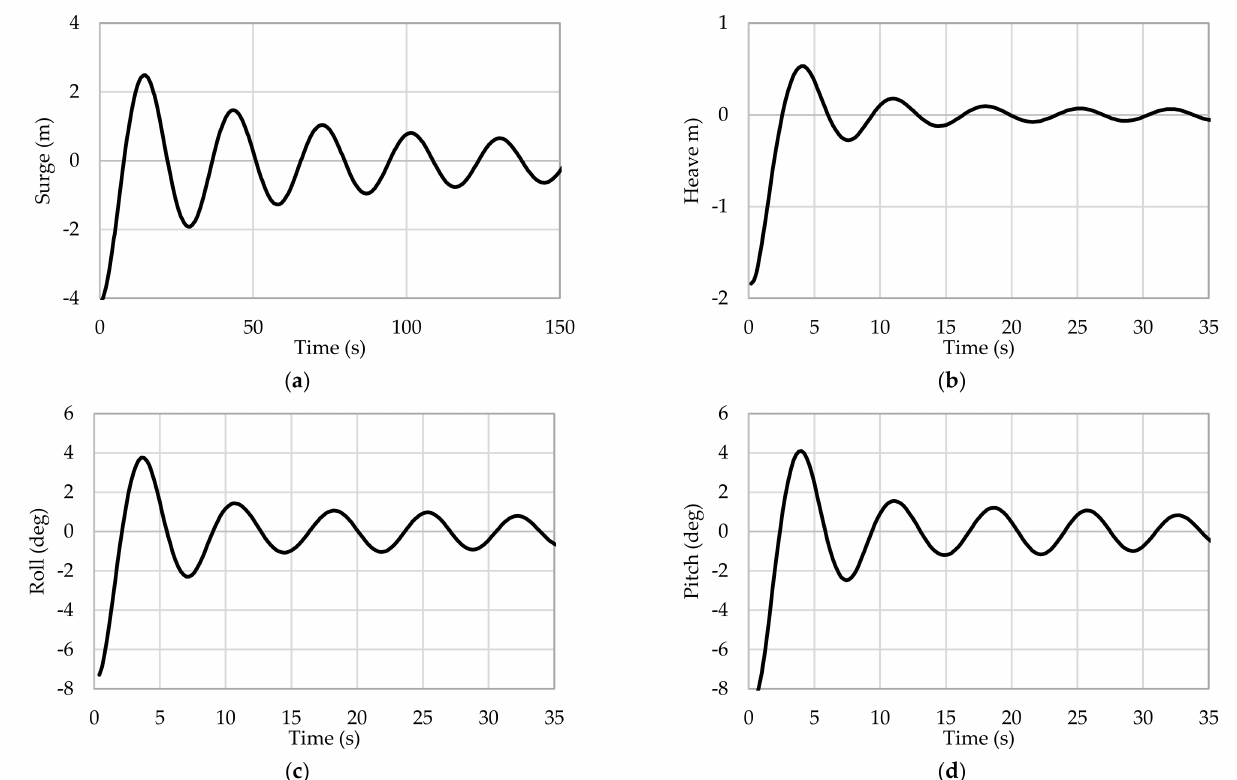
Figure 6. Mooring buoy decay time histories after the buoy system viscous damping, calibrated with the wave basin test results: ( a ) surge; ( b ) heave; ( c ) roll; and ( d ) pitch.